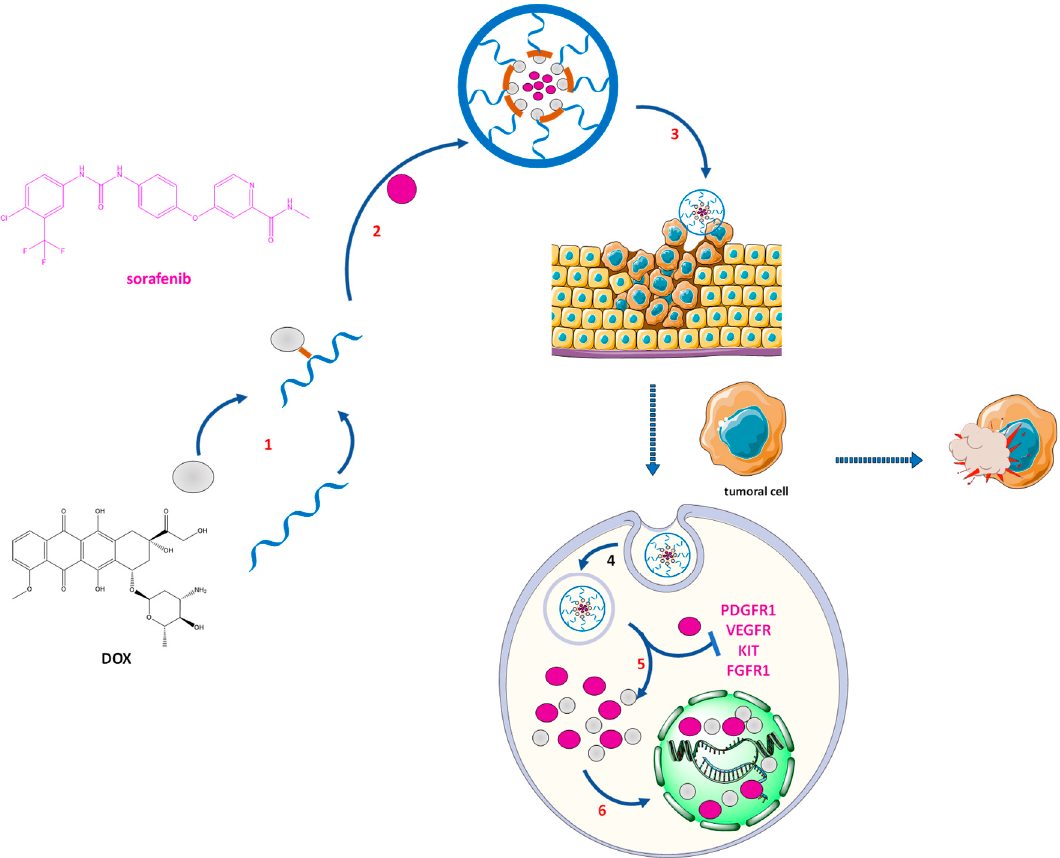
Figure 11. Doxorubicin–sorafenib co-loaded nanoparticles and their synergic mechanism of action [179,182] DOX—doxorubicin; FGFR1—fibroblast growth factor receptors; KIT—tyrosine-protein kinase; PDGFR1—platelet-derived growth factor receptors; PL—pullulan; VEGFR—vascular endothelial growth factor. 1—doxorubicin-pullulan conjugation; 2—self-assembly of the NP with sorafenib; 3—membrane invagination; 4—endocytosis; 5—drug release; 6—DNA targeting.Lately, many conjugates were synthetized between modified PL and cytotoxic molecules, which were actively